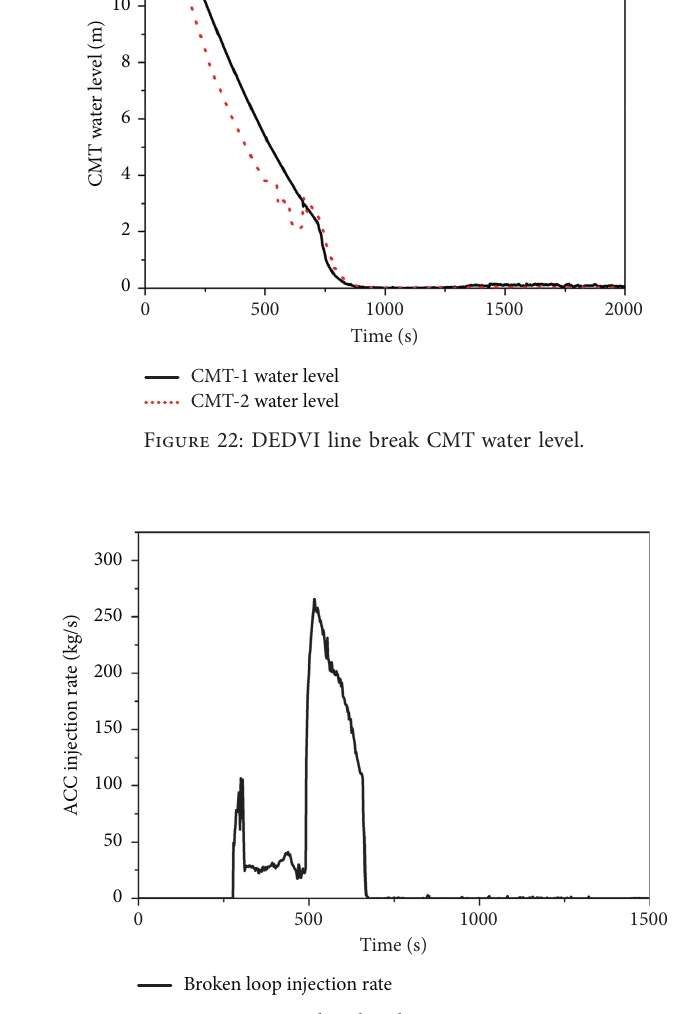
Figure 23: DEDVI line break ACC injection